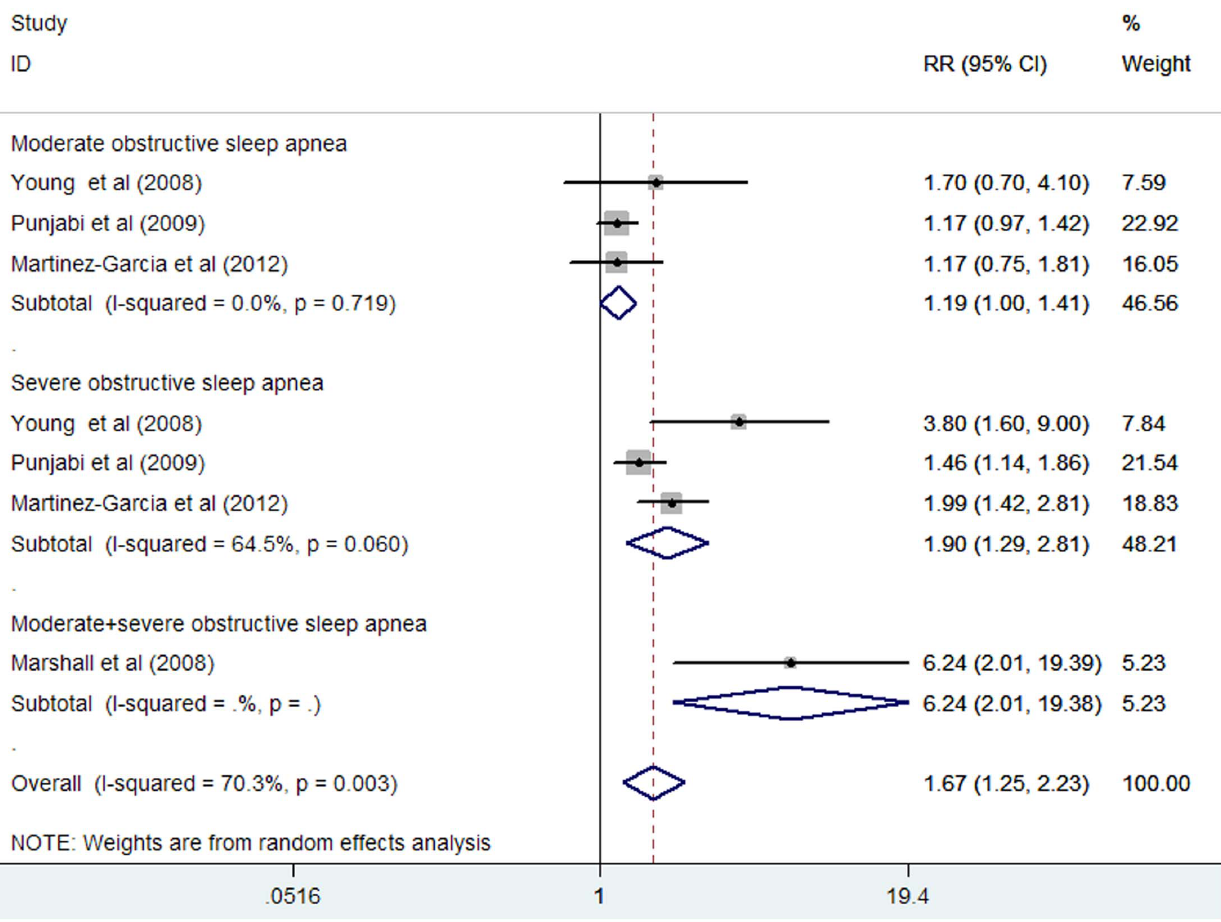
Figure 2. HR and 95% CI from the included studies of moderate and severe OSA with all-cause mortality comparing OSA to the